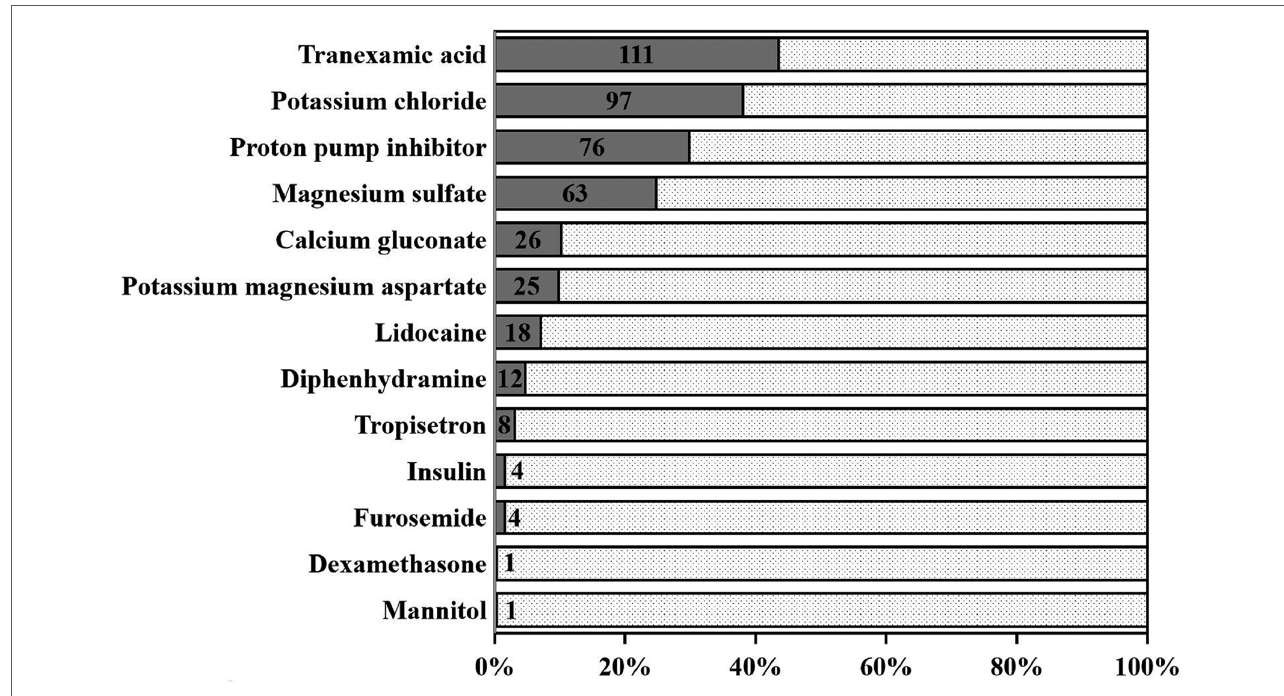
FIGURE 7 Adjuvant drugs. Tranexamic acid (111/255, 43.5%), potassium chloride (97/255, 38.0%), and proton pump inhibitor (76/255, 29.8%) were the most frequent adjuvant